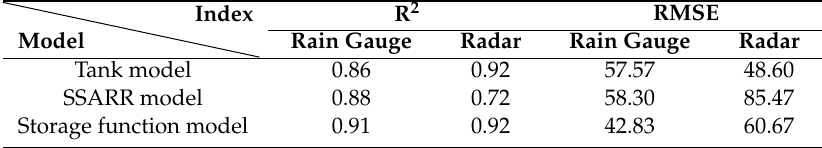
Figure 10. Runo ff hydrograph using storage function model. Figure 10. Runoff hydrograph using storage function model. Figure 10. Runoff hydrograph using storage function model. Figure 10. Runoff hydrograph using storage function model. Table 2. Performance statistics of initial runo ff Table 2. Performance statistics of initial runoff simulation. Table 2. Performance statistics of initial runoff simulation. Table 2. Performance statistics of initial runoff simulation.